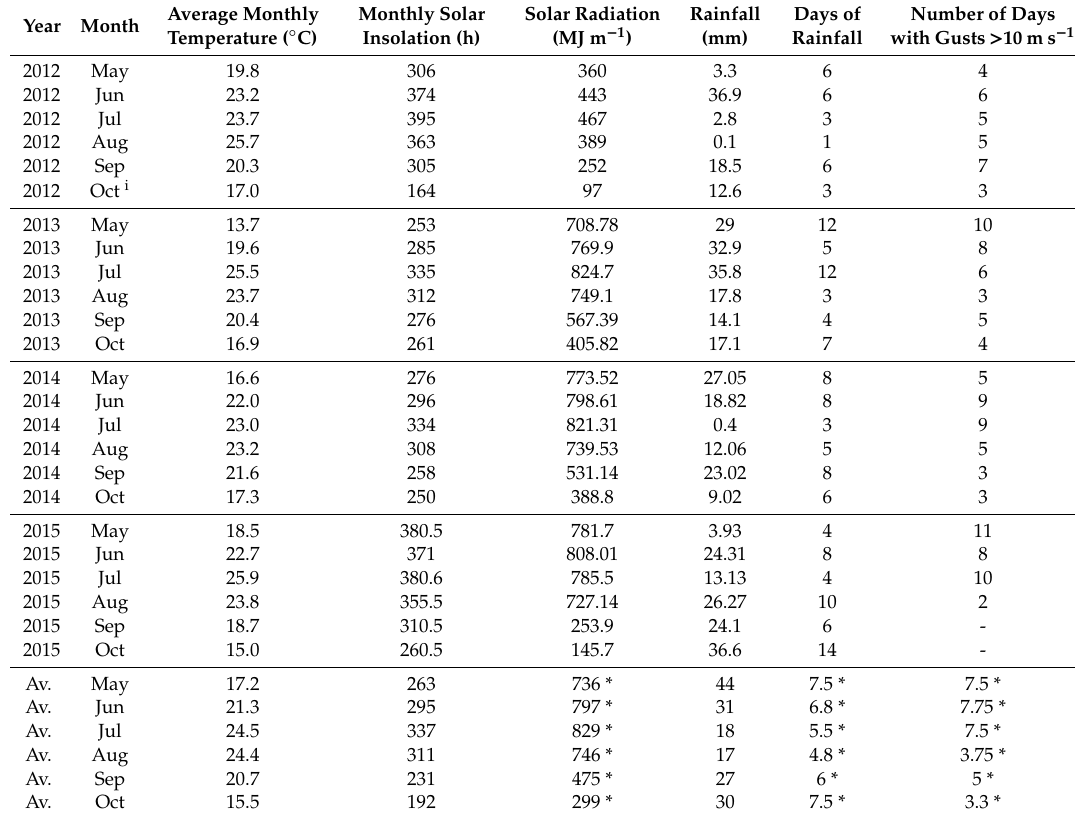
Table 1. Average monthly temperature ( ◦ C), monthly solar radiation (h), solar radiation (MJ m − 1 ), rainfall (mm), days of rainfall, and number of days with gusts > 10 m s − 1 from May to October from 2012 to